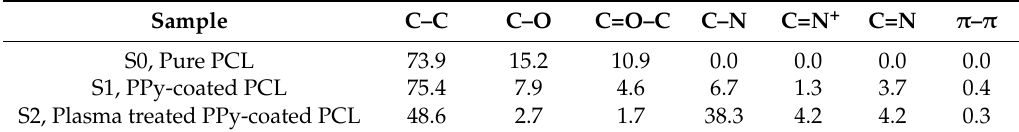
Table 2. The percentage of different bonds at C 1 s spectra for pure PCL, PPy-coated PCL and plasma-treated PPy-coated PCL. The amount of non-polar C–C bonds on PPy-coated PCL was decreased after plasma treatment from 75.4% to 48.6%, while the polar bonds of C–N and C=N + were significantly increased.